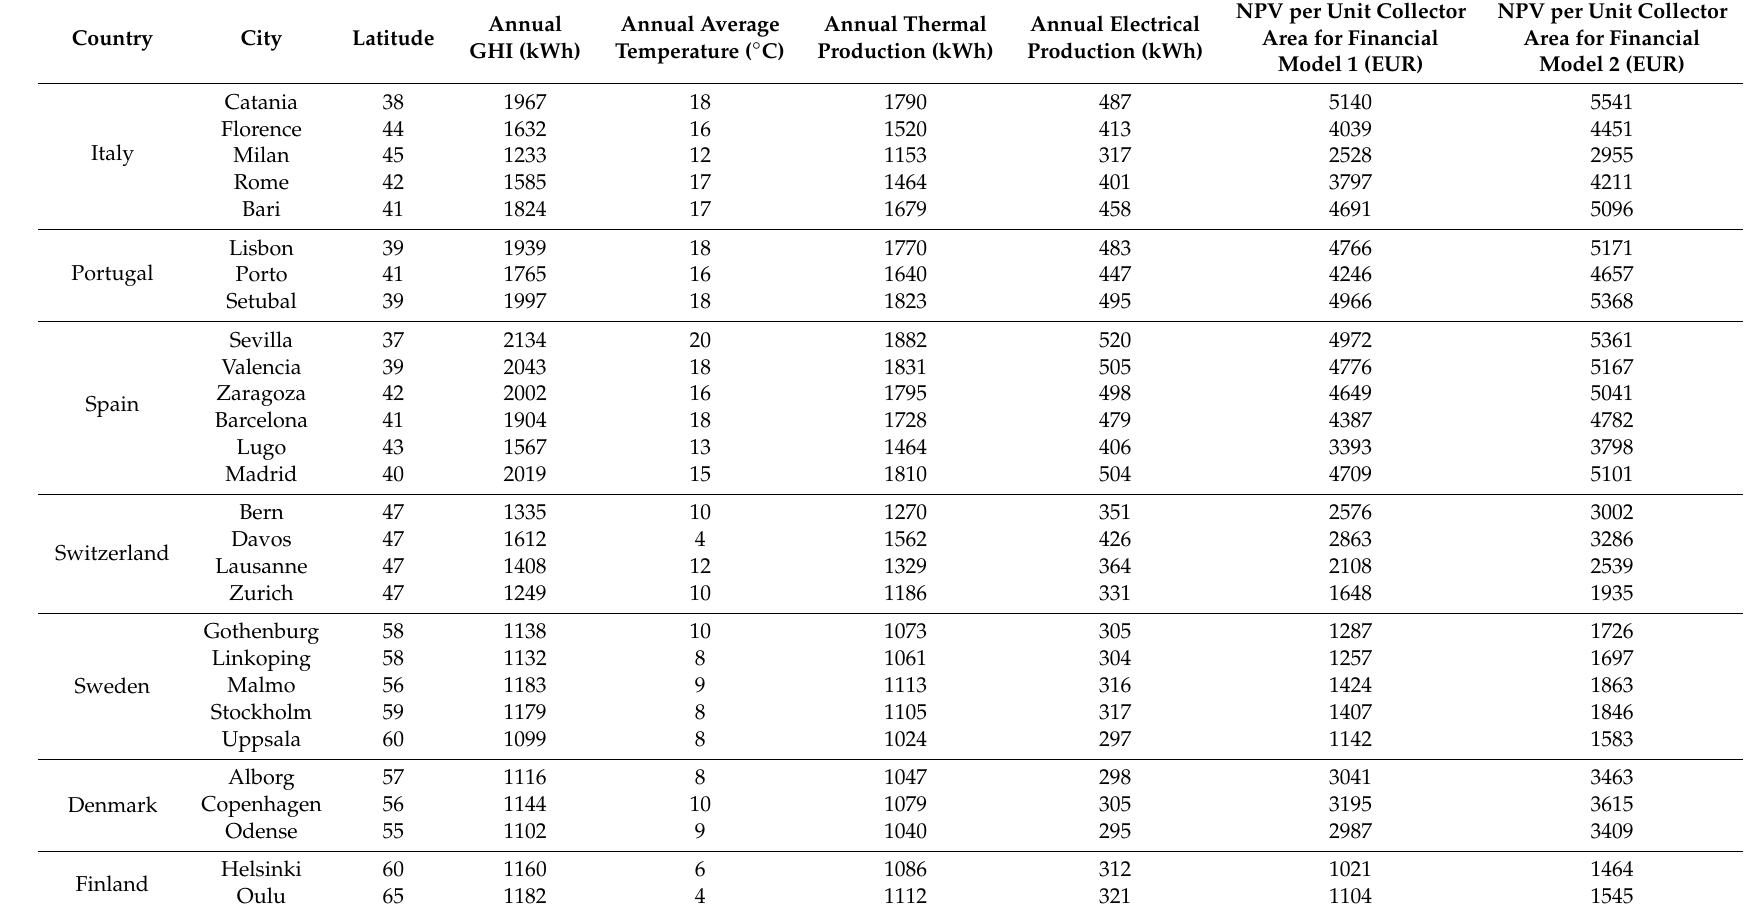
Table 5. All simulated data of key performance